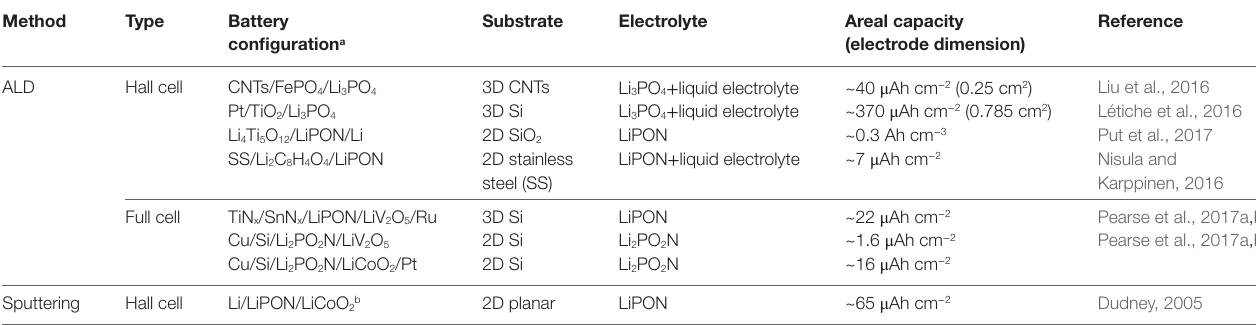
TABLe 1 | Solid-state battery configurations and areal capacities by atomic layer deposition (ALD) and other methods.